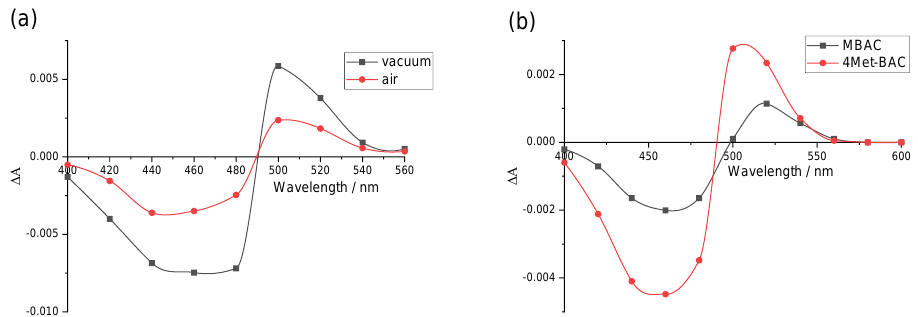
Figure 8. Differential transient absorption spectra of 4Met-BAC (7 × 10 −7 M) in air-equilibrated solvents (green – propanol-1, black – toluene, blue- acetonitrile) 100 ms after flash. Deaerating the compound solution only resulted in increased signal intensity in the case of propanol-1 (Figure 9a), changing insignificantly in acetonitrile and toluene (data not shown).